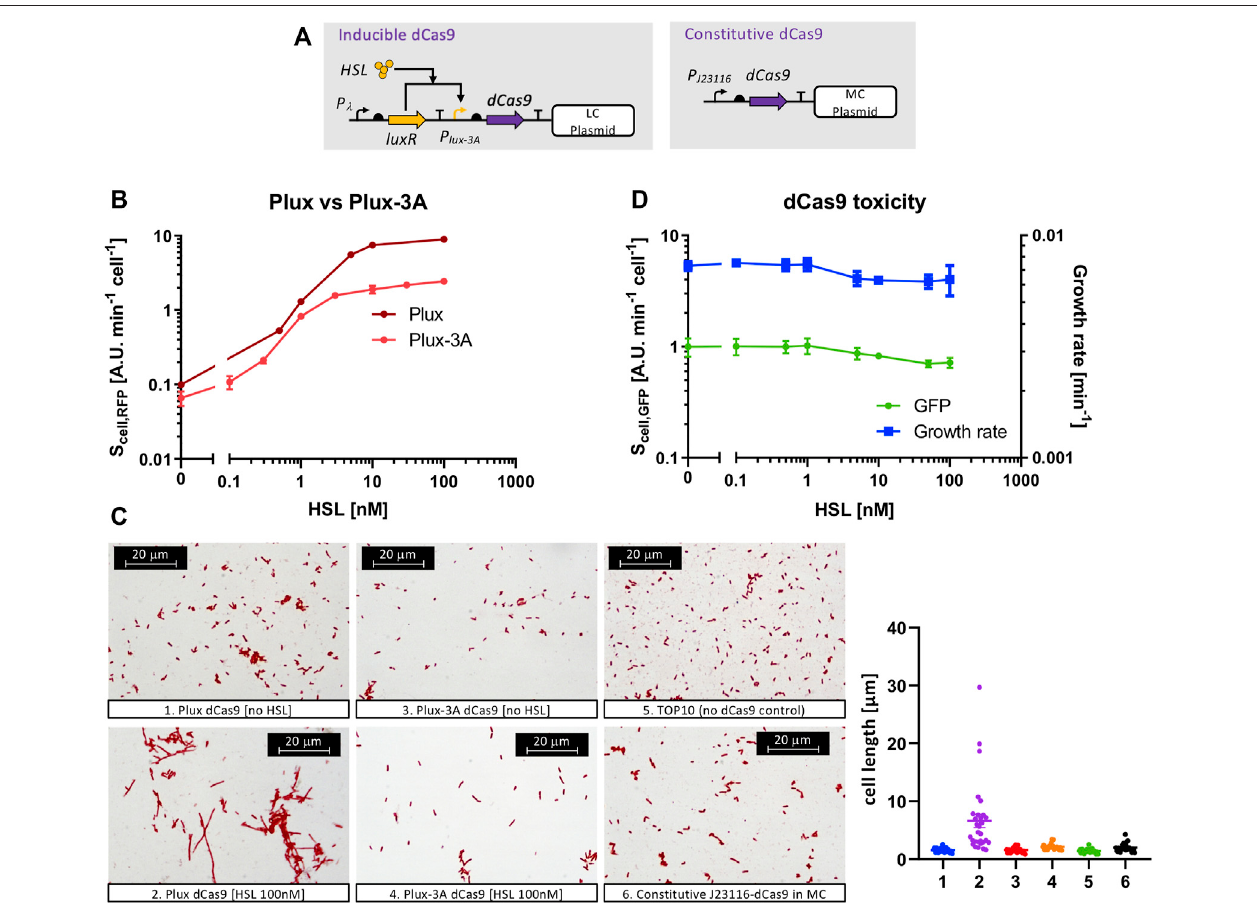
FIGURE3| ModelsystemstostudythephenotypiceffectsofdCas9intermsofcellloadandtoxicity. (A) SyntheticcircuitsfortheHSL-inducible(left)orconstitutive (right)expression ofdCas9.Straightarrows represent protein-codinggenesorsgRNA,curvedarrows represent promoters, halfovalsrepresentribosome bindingsites, T shapes represent transcriptional terminators. Thin truncated arrows represent repression. The HSL-inducible construct also includes a constitutively expressed GFP as cell load monitor, not shown in the scheme. P λ acts as a strong constitutive promoter for LuxR expression; P J23116 is a weak constitutive promoter; P lux-3A is similartothewild-typeP lux promoterbutwithoutthreeadeninesafterthetranscriptionstartsite. (B) Transferfunctions,withRFPasoutput,oftheHSL-induciblesystems including P lux or P lux-3A ,asindicated(strains Hrand H -3 r).Dataareshown asthe averageRFP synthesisrate per cell, asafunction ofHSL. (C) Microscopyimages ofthe indicatedrecombinantstrainstoobservemorphologicalchangesincelllengthrelatedtodCas9-inducedtoxicity.Thegraphontherightshowsthecelllengthdistribution of 30 sampled cells of each picture. Data points indicate the individual cell length values, thick line indicates the mean value and error bars the standard errors of the mean, (D) GrowthrateandGFP(expressedastheaverageGFPsynthesisratepercell),ascellloadindexes,forthestrainbearingthedCas9induciblecircuit(H -3 dstrain) asafunctionofHSL.Inpanels (B) and (D) ,datapointsrepresenttheaveragevalueanderrorbarsrepresentthestandarderrorsofthemeanofatleastthreeindependent